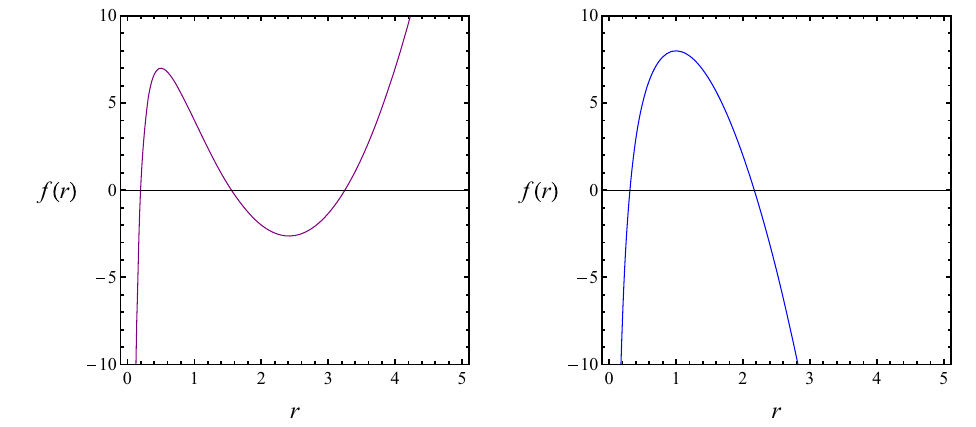
Fig. 1 The left panel shows the horizon structure of the AdS solution for specific values of the parameters where α 2 m = 4 , c 0 = 6 , c 1 = 5. The right panel shows the horizon structure of the dS solution for the value of the parameters as α 2 m = − 4 , c 0 = − 3 , c 1 =